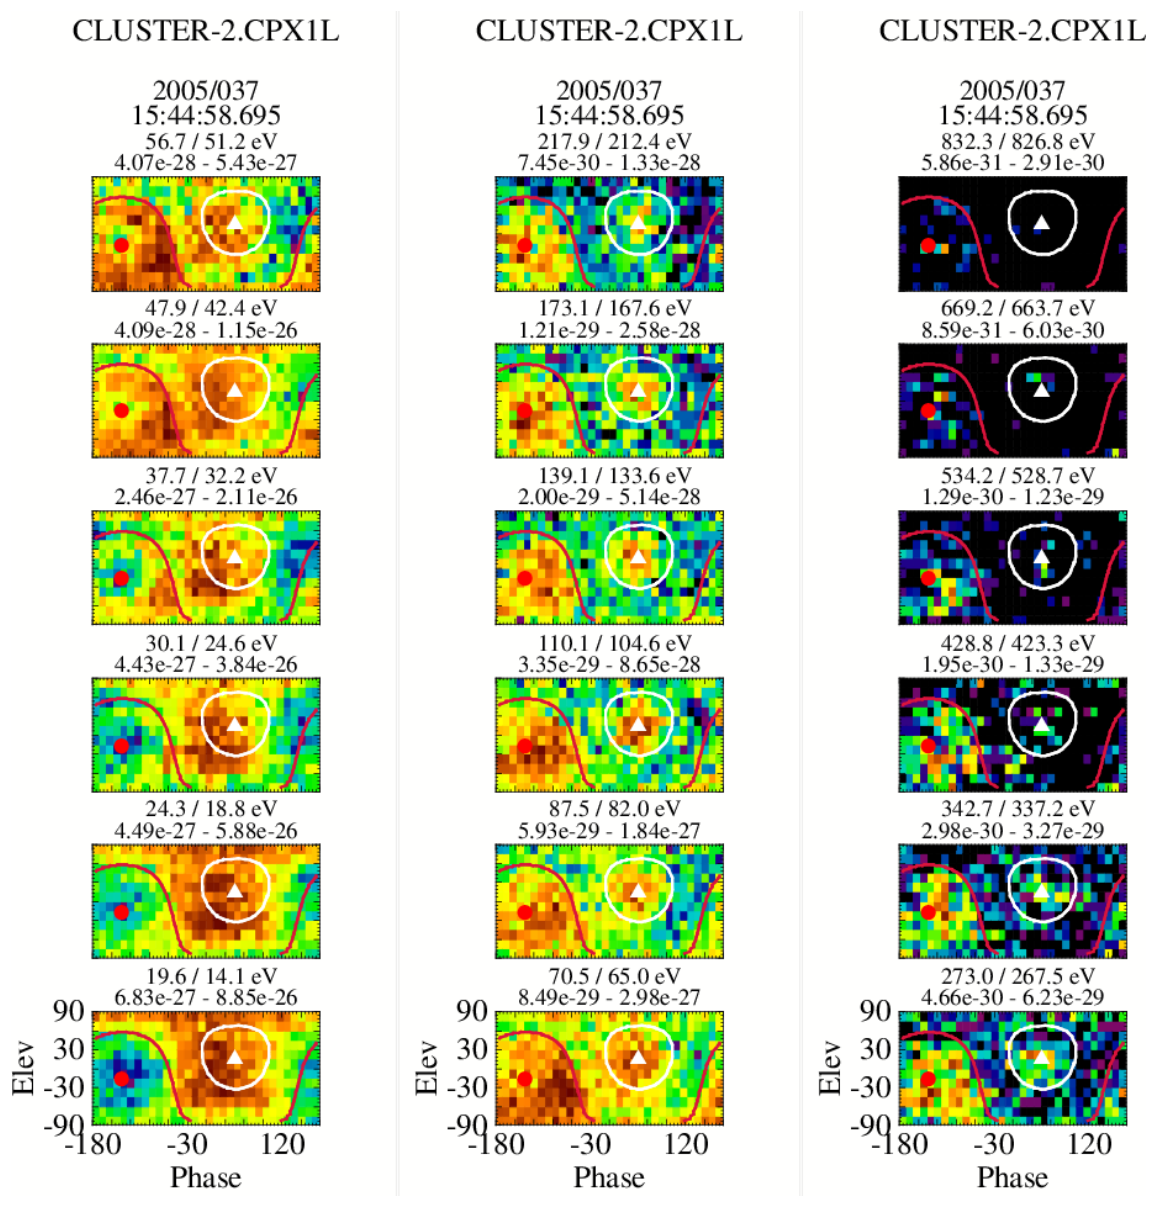
Figure 8. A set of φ – θ plots showing each energy step from 15.8 to 669.2eV from a single eVDF in the foreshock. The white and red traces are lines of constant pitch angles (130 and 75 ◦ ) and are shown solely to indicate the areas where the strahl (red) and return electrons (white) might be expected to be found. The presence of either population may not exist at any given energy. The solid triangle and dot in the plots are the projections of the tail and head of the magnetic field